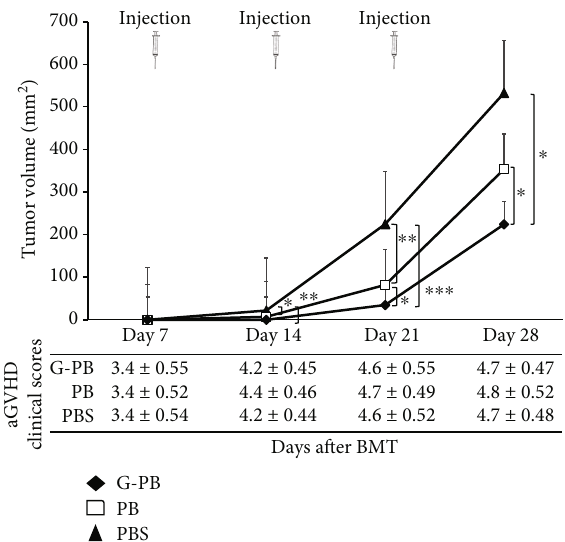
Figure 4: The tumor control of NK cells by neutrophils in vivo . The tumor was subcutaneously injected under the axilla at the same time as the BMT. PBS, PB, and G-PB were intraperitoneally injected on days 7, 14, and 21 after BMT to enhance the activity of NK cells. Tumor size measured using calipers and acute GVHD scores were checked on days 7, 14, 21, and 28. PBS: n = 12 ; PB: n = 10 ; G-PB: n = 10 . ∗ p < 0 : 05, ∗∗ p < 0 : 01, and ∗∗∗ p < 0 : 001